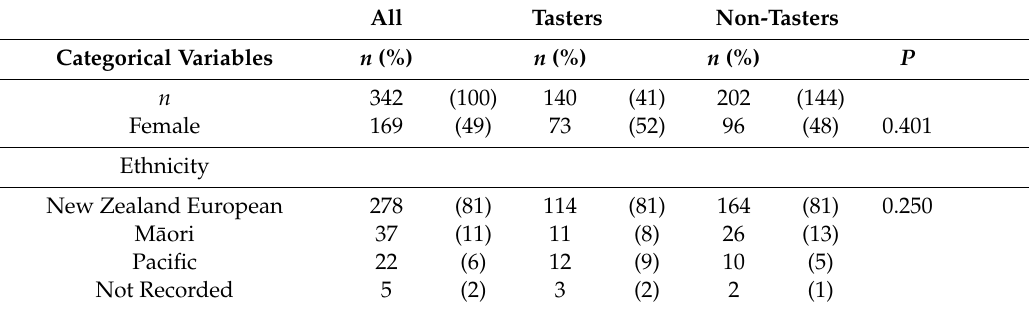
Table 1. Participant characteristics ( n =